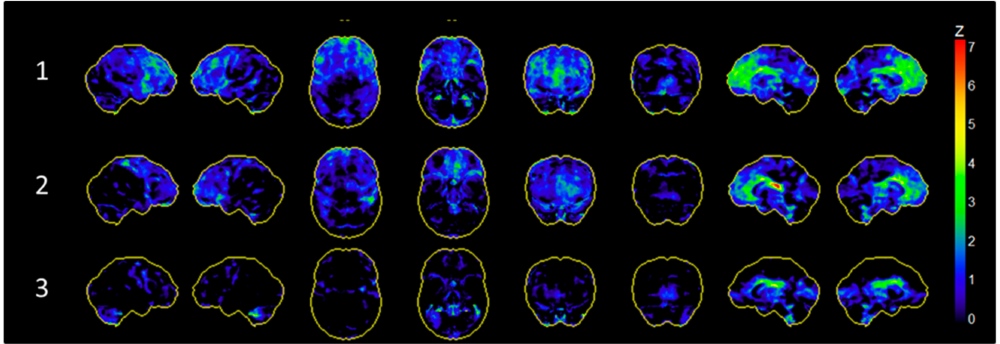
Figure 2. Glucose hypometabolism during stimulation OFF condition compared to an age-matched healthy control cohort. Patients showed most pronounced relative hypometabolism in the medial prefrontal cortex as well as the